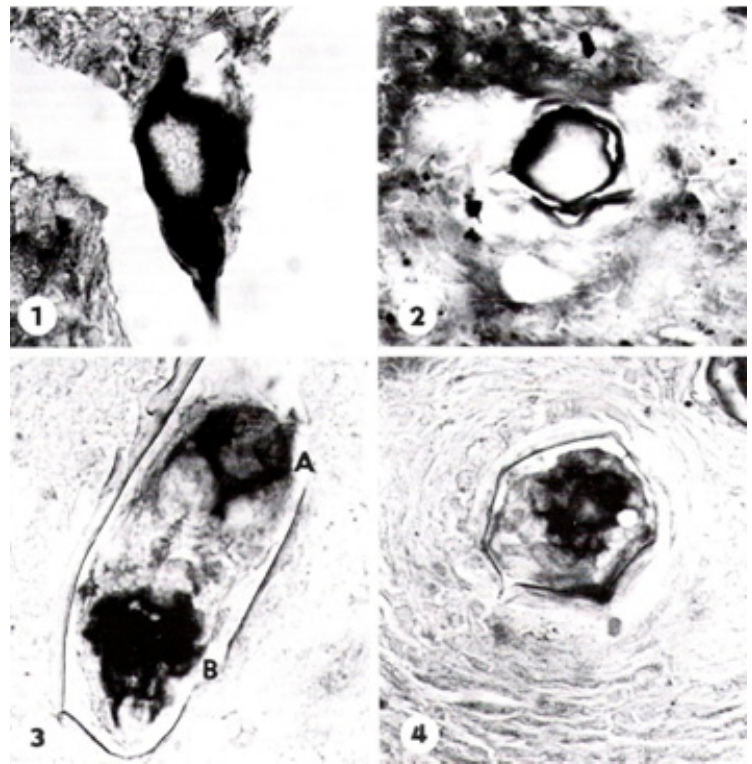
Figure 4. Activity of alkaline phosphatase (AP) in the body surface layer of the S. mansoni egg and in von Lichtenberg’s envelope stained by naphthyl AS-D phosphatase + Fast BB . ( 1 ) Immature eggs with developing miracidium—diagonal section (×640); ( 2 ) eggs with developing miracidium—transversal section (×miracidium. (500); ( 3 ) The site of alkaline phosphatase changed during the course of maturation of the miracidium. AlP was demonstrated in germ cells and in the sensory endings of neural cells, located only at the anterior part of miracidium (A and B) (×780); and ( 4 ) eggs with fully developed miracidium—transversal section (×780) showing AP bound to the germ cells in the posterior part of miracidium (reproduced from Folia Parasitologica (Praha) with permission).